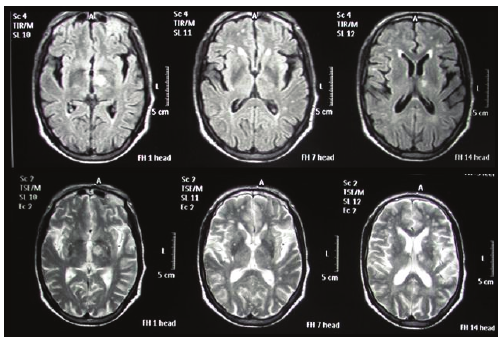
Figure 2: The second MRI (2 days after recent event) revealed another infarct area in left